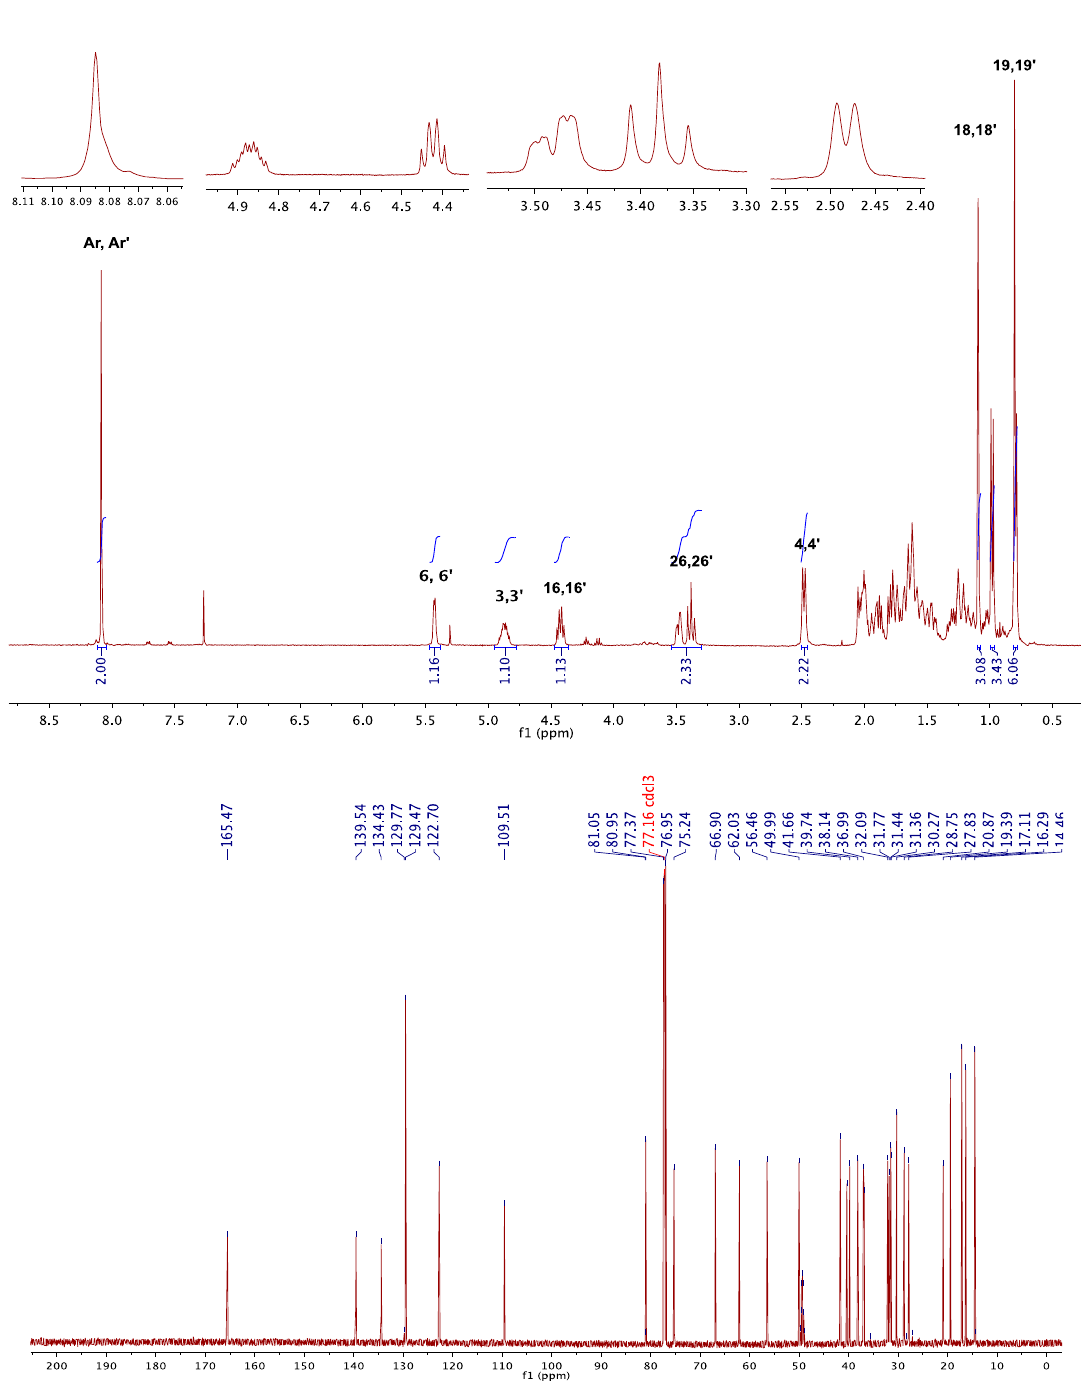
Figure 3. 1 H-NMR spectrum at 500 MHz in CDCl 3 of 8a with expansion in 8 ppm (top). 13 C-NMR spectrum at 125 MHz in CDCl 3 of 8a (bottom).